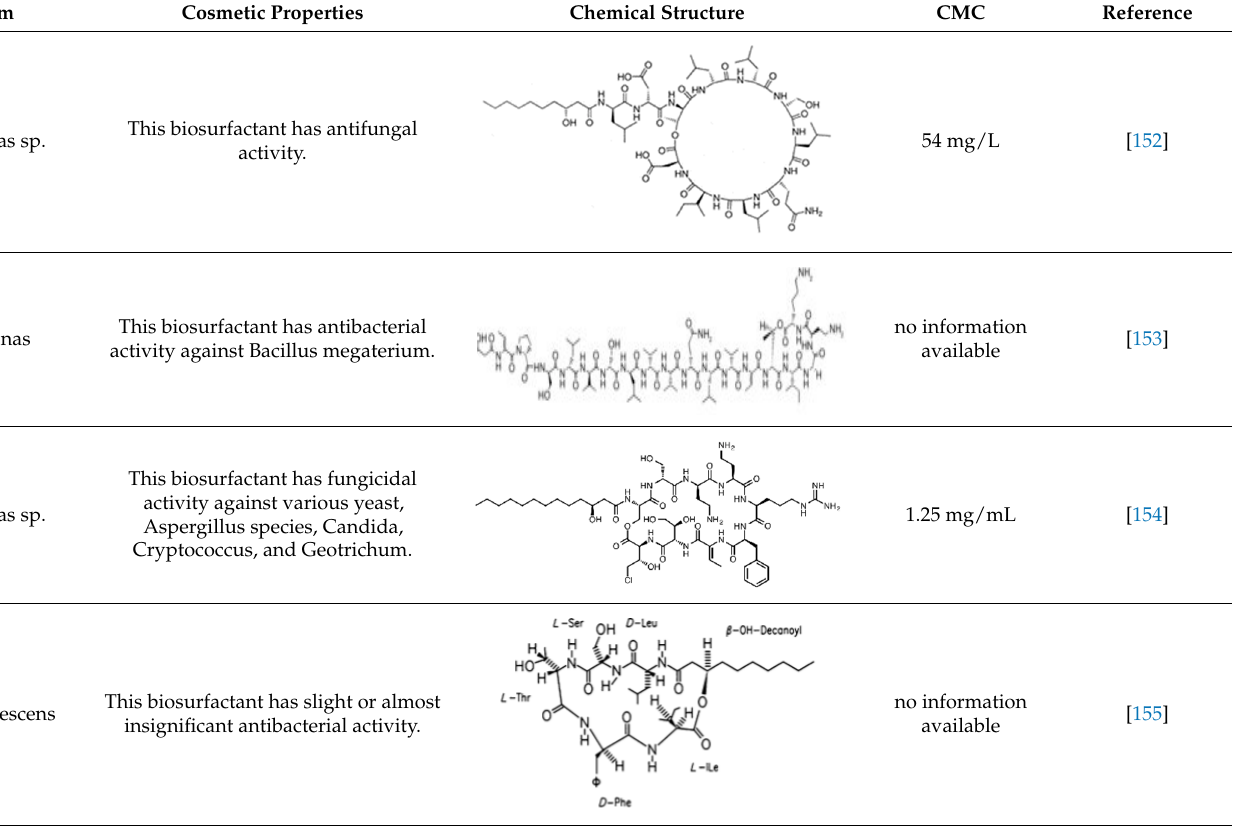
Table 4. Colloidal properties of common synthetic surfactants and biosurfactants.